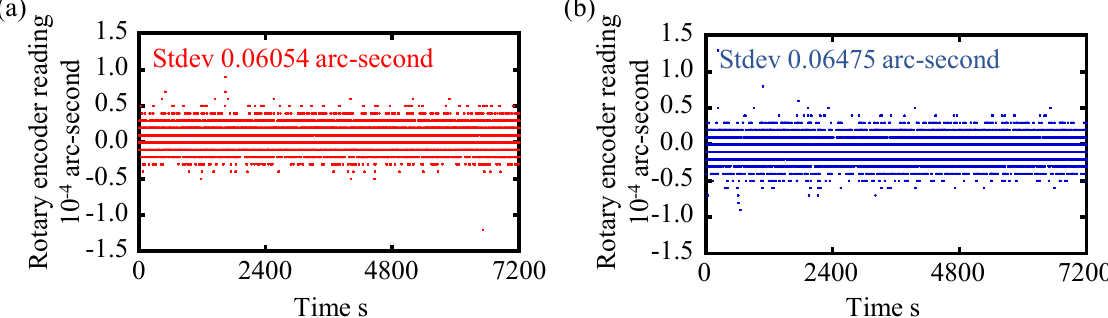
Figure 6. Reading of the rotary encoder embedded to the air-bearing spindle: ( a ) Positive first-order Littrow configuration; ( b ) Negative First-order Littrow configuration.